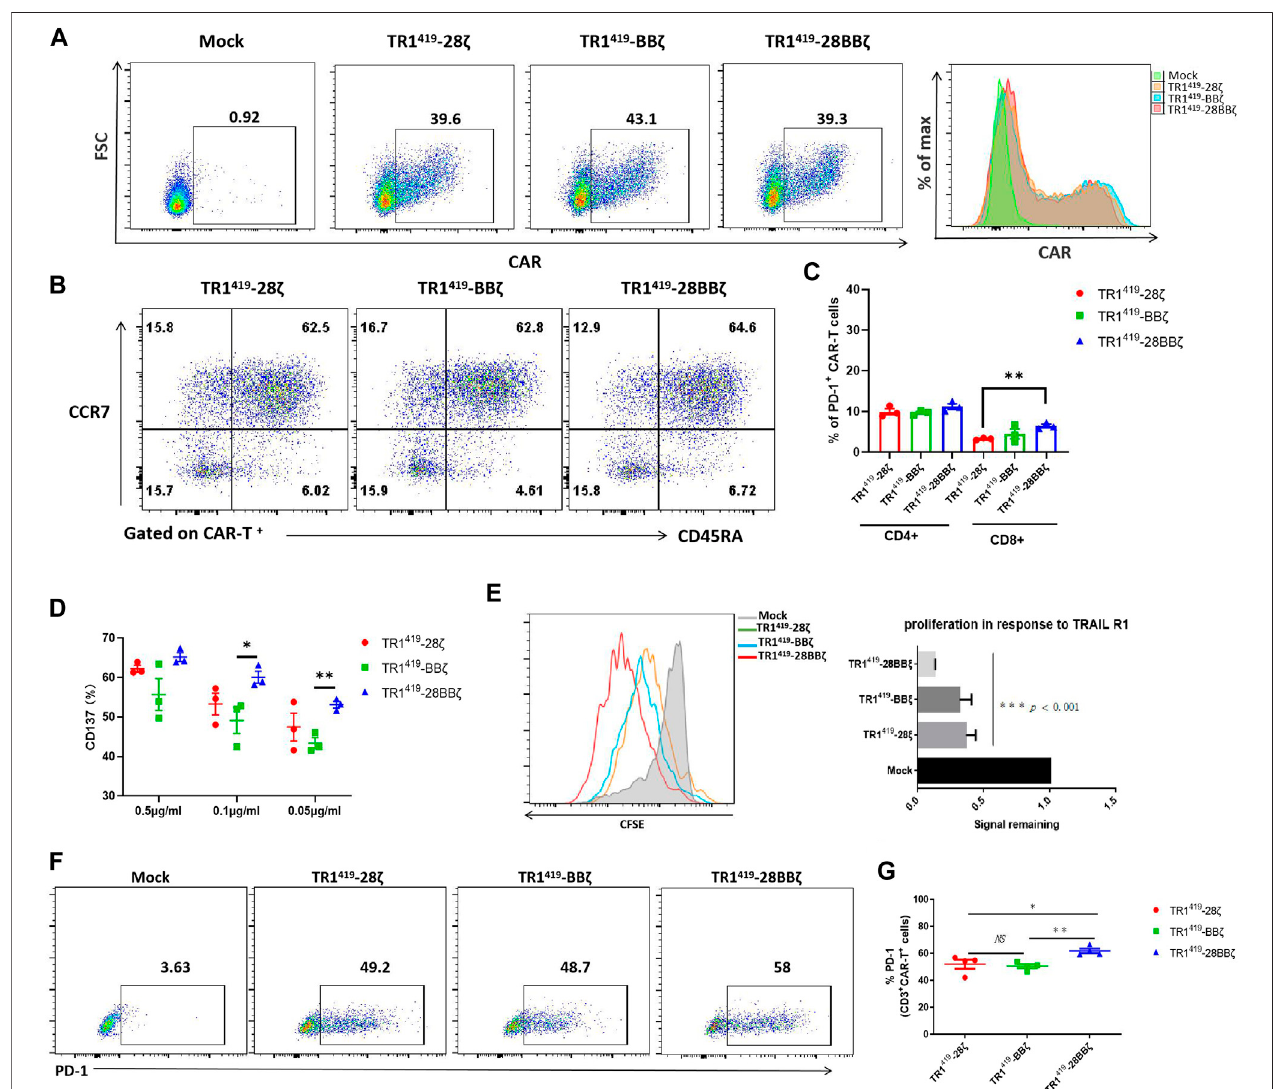
FIGURE 1 | TR1 419 -28BB ζ CAR-T cells exhibited functional advances upon antigen stimulation. (A) Untransduced Mock T cells or TRI 419 -28 ζ TRI 419 -BB ζ CAR-T cellswereevaluatedby fl owcytometryfortheTRI 419 scFvexpression. (B) RepresentativeCAR-TcellphenotypingwasplottedbasedonCD45RAandCCR7expression. CD45RA + CCR7 + : naive-like T cells; CD45RA − CCR7 + : central memory T cells; CD45RA − CCR7 - : effector memory T cells; and CD45RA + CCR7 - : effector T cells. (C) Quali fi cation of inhibitory molecule PD-1 expression on CD4 + CAR and CD8 + CAR-T cells on day 7 post lentiviral transfection. (D) Flow cytometric analysis of CD137 expression on TR1 419 CAR-T cells cultured overnight with plate-bound recombinant human TRAIL-R1 at various concentrations. (E) TR1 419 CAR-T-cell proliferation,indicatedbydivisionofCFSE,afterculturedwithSW480for7 dayswasassessedby fl owcytometry.Thesignalremainingvaluecorrespondedtothemean fl uorescenceintensityoftheCFSEofmockTcells. (F – G) TheexpressionofPD-1onTRI 419 CAR-TcellswasanalyzedbyFACSafter7 daysofcoculturewithtumorcells. Data are given in the mean ± SD of three independent experiments, * p < 0.05, ** p < 0.01.